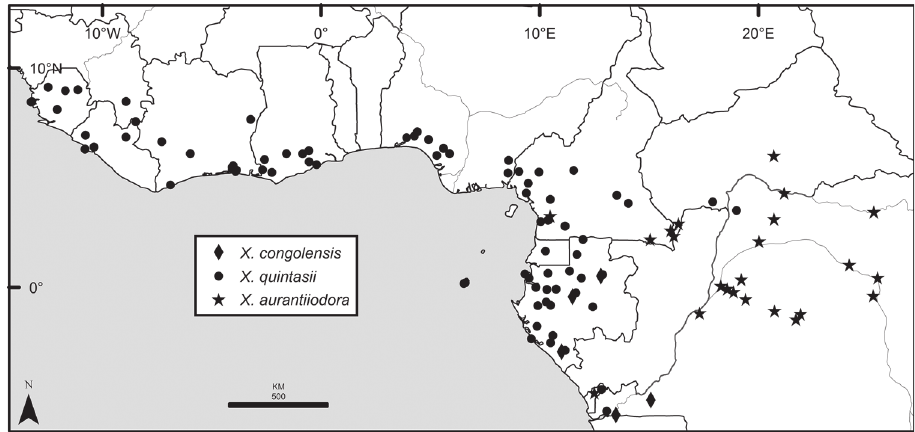
Figure 15. Distributions of Xylopia aurantiiodora , X. congolensis , and X. quintasii . Bolder lines represent country borders, fainter lines lakes and major